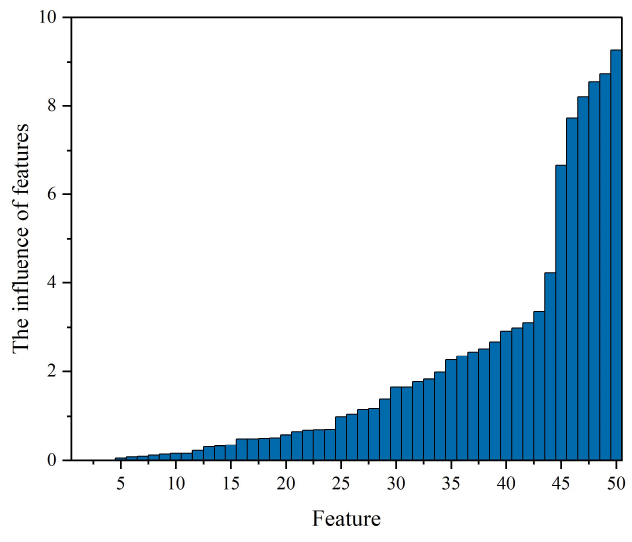
Figure 4. The influence of each feature. Table 3. The 50 features in Figure 4.